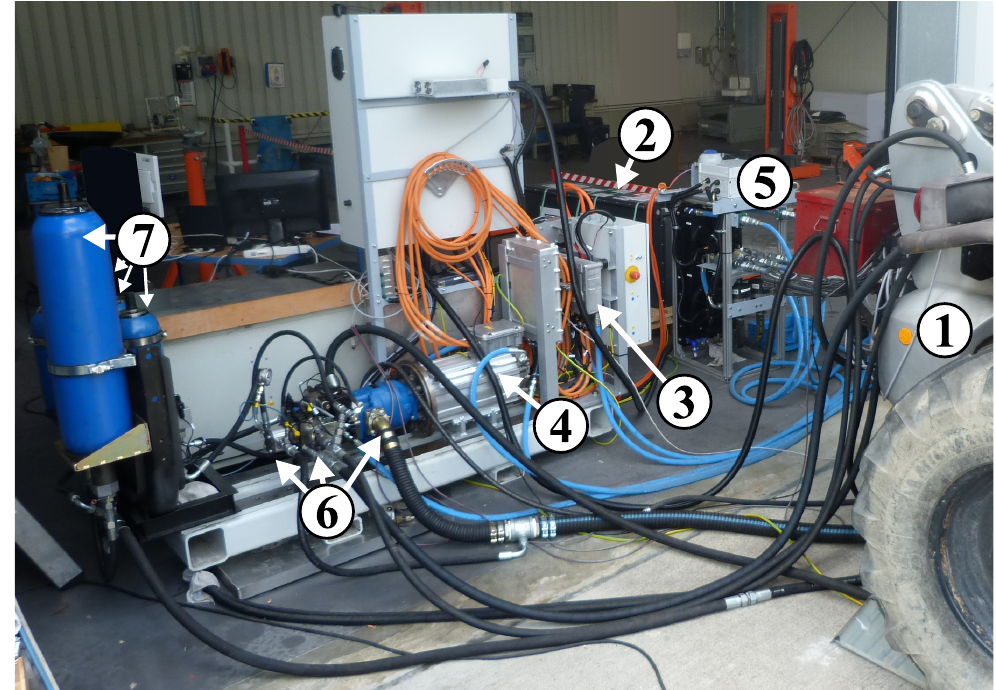
Figure 2. Electro-hydraulic rig and hydraulic connections to the telehandler (1). Further compo- nents/assemblies: 680 V Battery (2), inverter (3), motor (4), air-liquid cooling unit (5), hydraulic pumps, and valve block (6), as well as four hydraulic accumulators